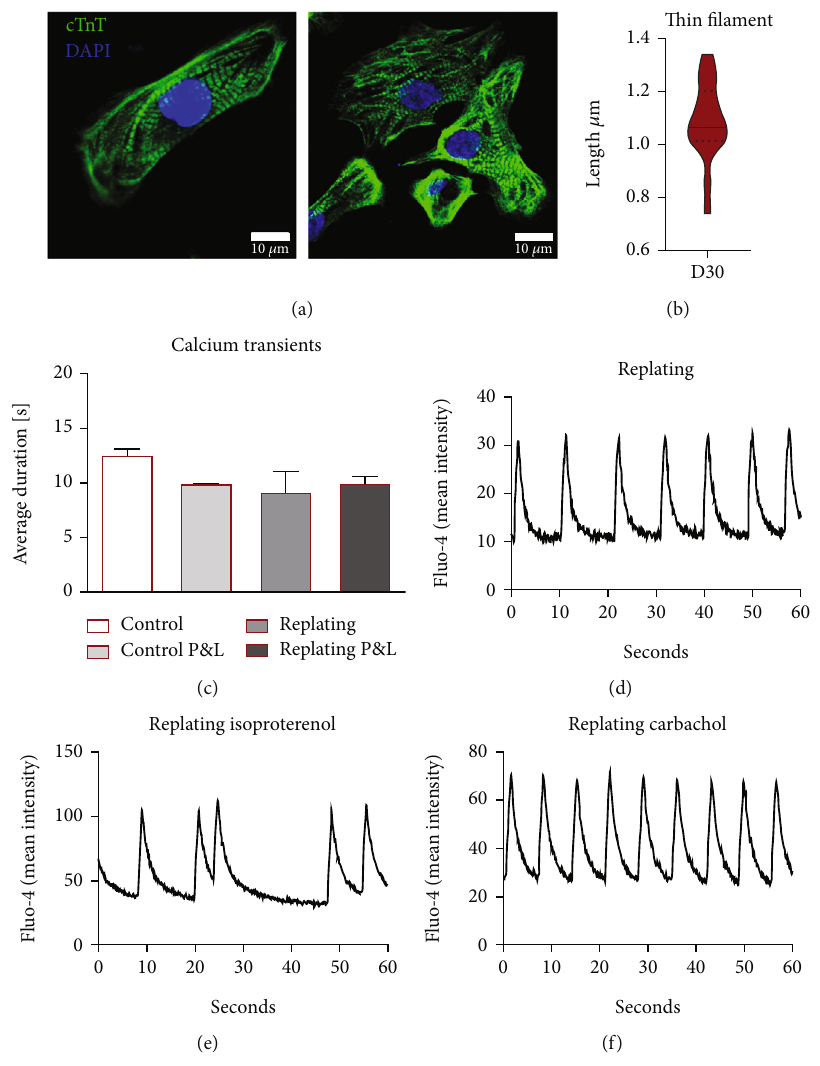
Figure 4: Structural and calcium transient analysis of hiPSC-derived cardiomyocytes. (a) Analysis of hiPSC-CM cardiac fi bers organization at day 30 by confocal microscopy. A mixed population was observed. (b) Thin Filament length (cTnT bands) measured at day 30. Violin plot displays median and quartiles, n = 17 cardiomyocytes from two independent experiments. (c) Calcium transients measured at day 20 showed a similar average duration for all di ff erentiation conditions. Error bars, SEM: n = 8 Control, n = 3 Control, P&L, and replating, n = 4 replating and P&L (ANOVA). (d) Representative calcium transient pro fi le for replating, showing an average time between transients of 9.3, SD ± 0 : 9 . (e) When 1 μ M isoproterenol was supplemented, arrhythmic behavior was observed for a few samples, with some cardiac sheets showing arrested contractibility and calcium transients. Figure shows an average time between calcium transients of 11.6, SD ± 8 : 6 . (f) When 1 μ M carbachol was used, calcium transients showed a more consistent and synchronized pattern. Figure shows an average time between calcium transients of 6.9, SD ± 0 : 2